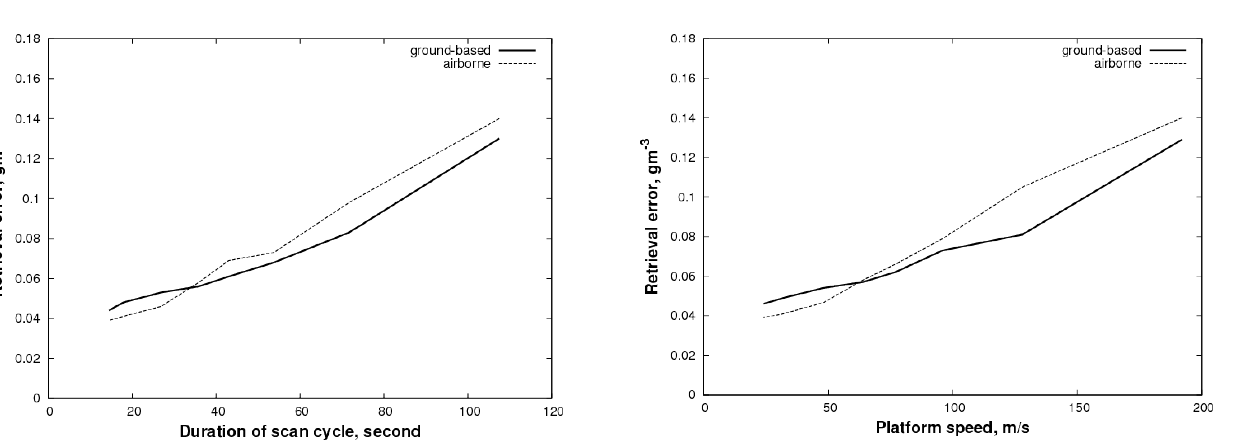
Figure 10. The retrieval error as a function of the speed of platform motion. A slower platform provides more accurate retrieval at the expense of longer data collection time and possible loss of ability to monitor rapidly-evolving clouds. The stratocumulus cloud case is used for this sensitivity test.